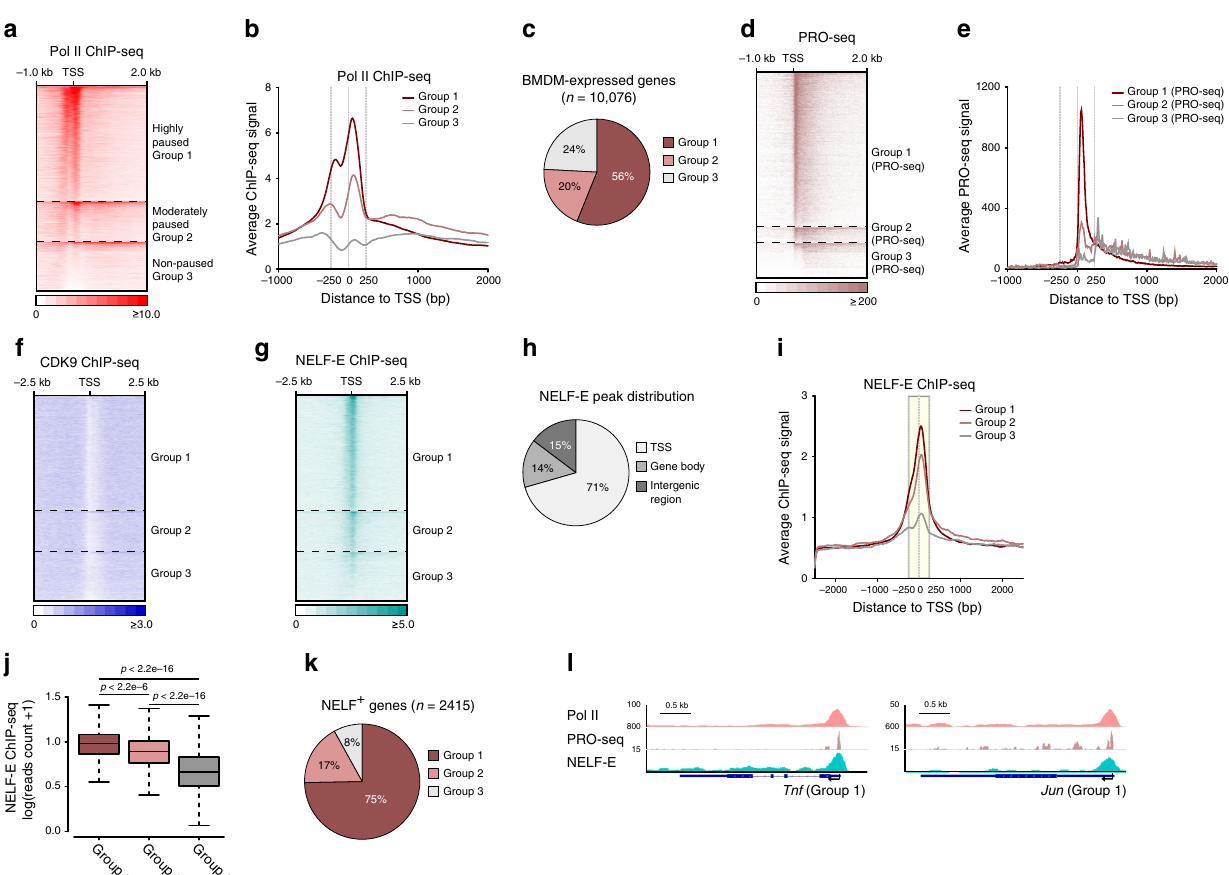
Fig. 1 Pol II promoter – proximal pausing in resting BMDM is marked by NELF co-localization. a Heat map of Pol II ChIP-seq signals around the TSS regions for BMDM-expressed highly paused (group 1), moderately paused (group 2), and non-paused (group 3) genes. Each row indicates one gene. In each group, the rows were sorted by the decreasing Pol II ChIP-seq signal in TSS region. b Average Pol II ChIP-seq signals around TSS regions of group 1 (brown), group 2 (red), and group 3 (gray) genes, as indicated. c Pie graph shows the percentage of BMDM-expressed genes in each group. d Heat map of PRO-seq signals (sense strand) around the TSS regions for three groups of genes classi fi ed based on PRO-seq de fi ned PI. Each row indicates one gene. In each group, the rows were sorted as in ( a ). e Average PRO-seq signals (sense strand) around TSS regions of group 1 – 3 genes from ( d ). f , g Heat maps for CDK9 ( f ) and NELF-E ( g ) ChIP-seq signals around the TSS regions for three groups of genes. In each group, the rows were sorted as in ( a ). h The genomic distribution of NELF-E ChIP-seq peaks. TSS and gene body regions were de fi ned as shown in Supplementary Fig. 1a. i Average NELF-E ChIP-seq signals around TSS of group 1 – 3 genes, as indicated. j NELF-E ChIP-seq reads quanti fi ed in − 250 to + 250 bp region (boxed in ( i )) are shown as box-plots for group 1 – 3 genes, as indicated. Boxes outline the data from fi rst quartile to third quartile, and bars indicate the boundary whose distribution does not exceed 1.5- fold of interquartile range extended from both fi rst quartile and third quartile. p Values (group 1/group 2 P < 2.2e − 16 , group 1/group 3 P < 2.2e − 16 , group